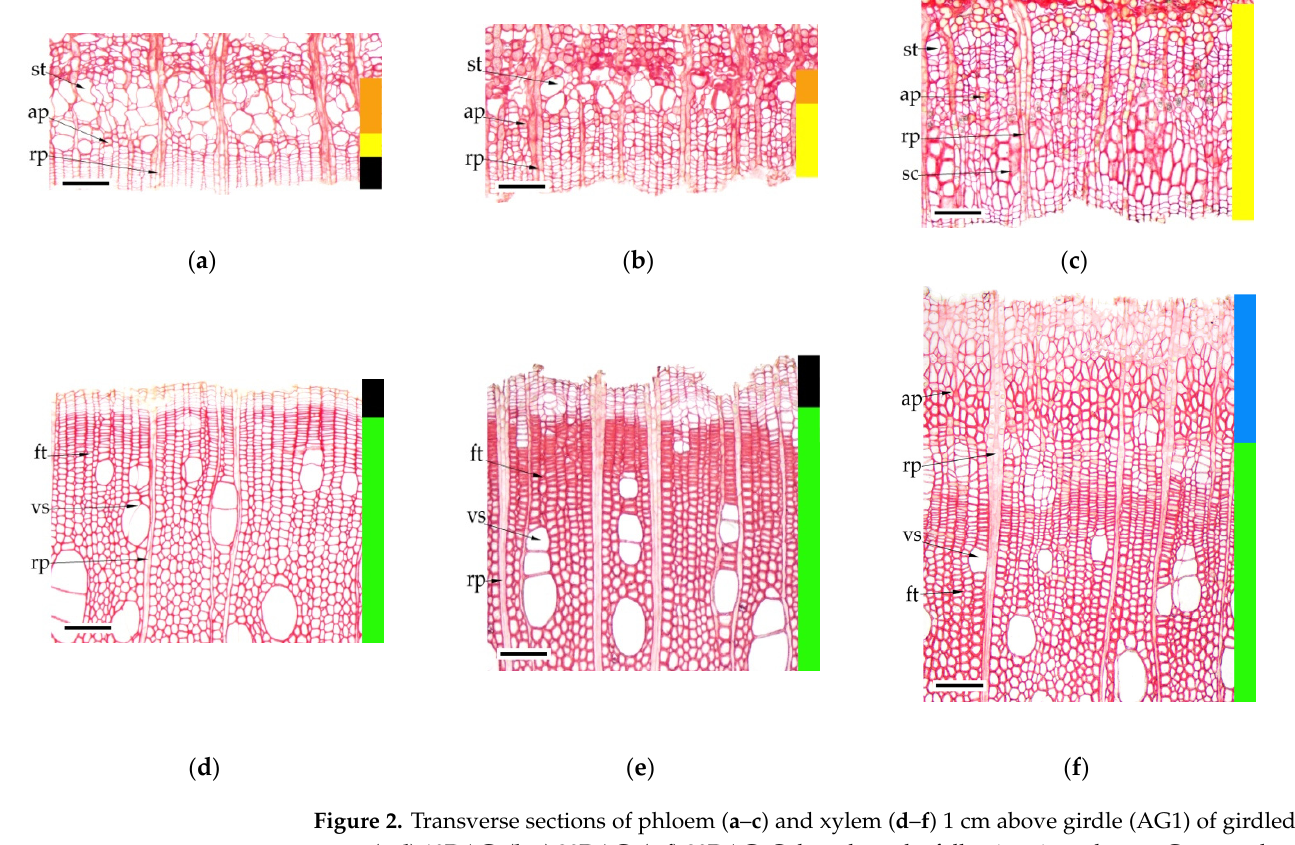
Figure 2. Transverse sections of phloem ( a – c ) and xylem ( d – f ) 1 cm above girdle (AG1) of girdled trees. ( a , d ) 10DAG; ( b , e ) 20DAG; ( c , f ) 30DAG. Colors show the following tissue layers. Green: xylem formed before the experiment; blue: xylem formed after the experiment; black: cambial zone; yellow: late phloem; orange: early phloem. The cambium is not defined in figures ( c , f ), because all the trees had tissue discontinuity along the cambium during sampling. The letters in the figures are vs: vessels; ft: fibrous tracheids; rp: ray parenchyma; ap: axial parenchyma; st: sieve tubes; sc: sclereids. Scale bar is 100 µm.